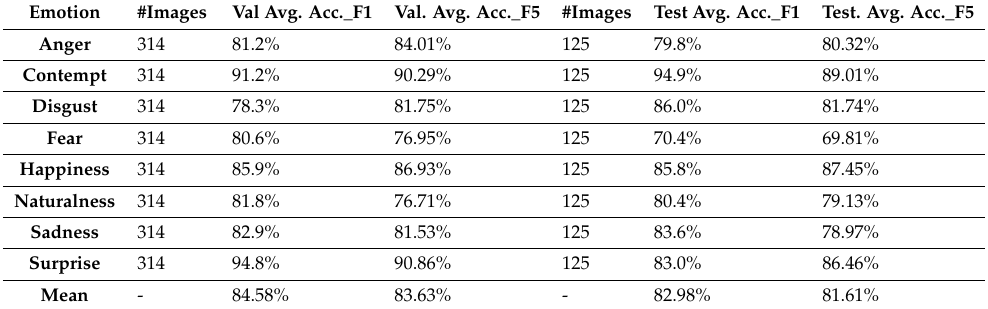
Table 6. Performance per class and average accuracy using both models, achieved with one-fold and five-fold cross-validation, on validation and test set from MIXED dataset with ELU activation function.